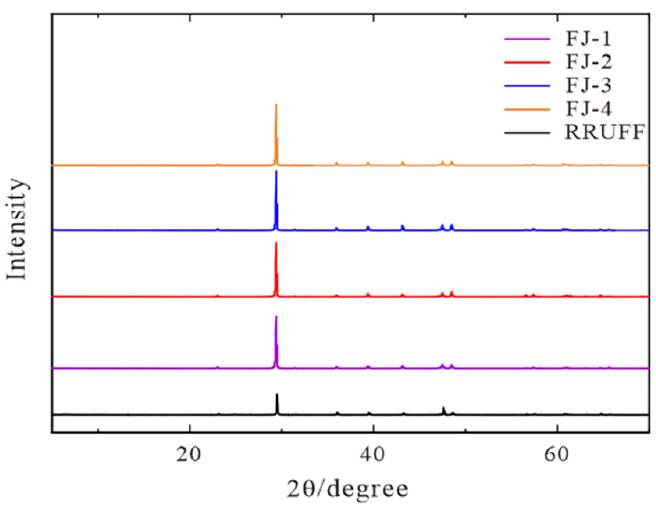
Figure 4. XRD diffraction patterns of FJ-1, FJ-2, FJ-3, and FJ-4, RRUFF standard pattern are listed for comparison.